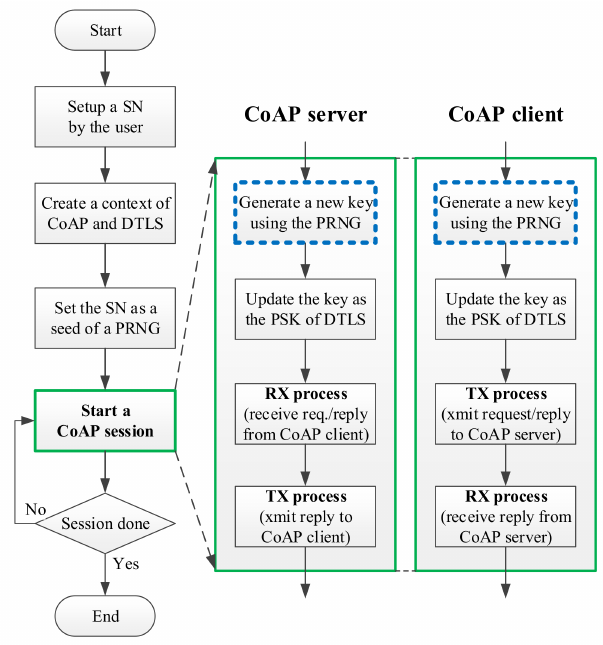
Figure 8. Flowchart of key updating in CoAP session.